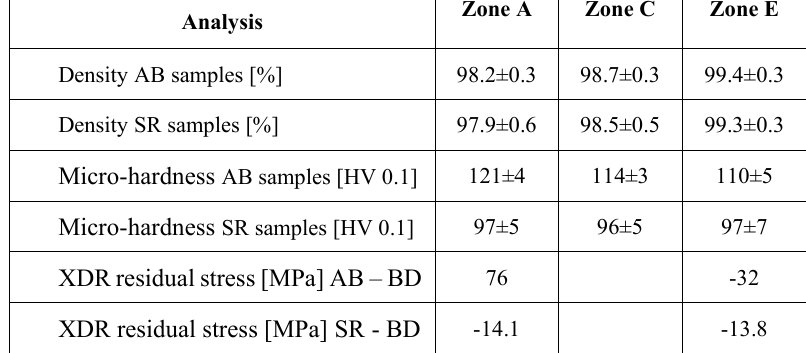
Table 2. Density, micro-hardness, and residual stress on the different zones